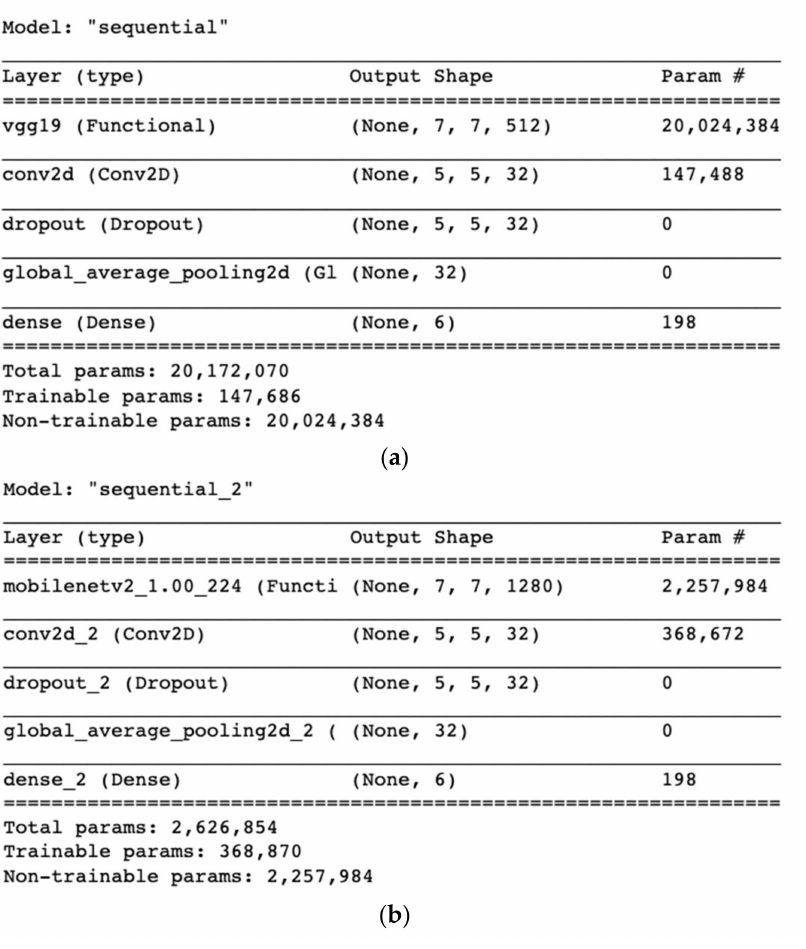
Figure 7. The structure and parameters of the neural network test models based on MobileNet v2 and VGG-19 models. ( a ) The test model based on MobileNet v2 model. ( b ) The test model based on VGG-19